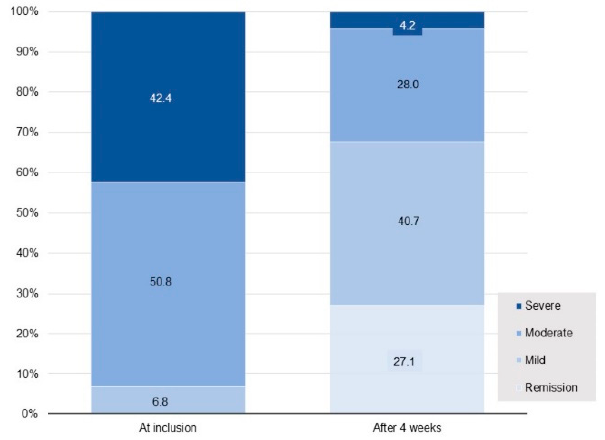
Figure 4. Evolution of IBS severity between inclusion and the end of the 4th week of supplementation. Percentages of patients with IBS rated as severe (IBS-SSS score: [300–500]), moderate (IBS-SSS score: [175–299]), or mild (IBS-SSS score: [75–174]) and percentage of healthy patients (IBS-SSS score: <75, corresponding to remission) at inclusion and after 4 weeks of supplementation. Patient distribution between IBS-SSS classes at 4 weeks differed to a statistically significant extent from that observed at inclusion ( p < 0.0001).